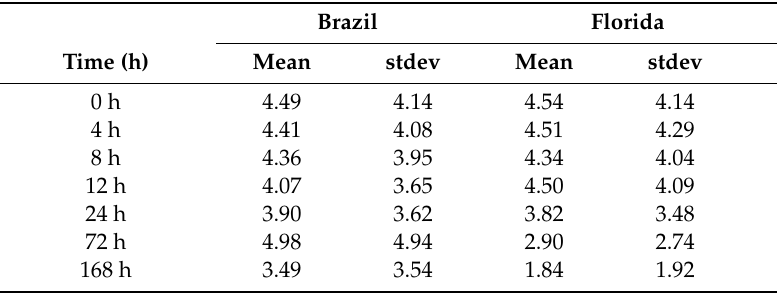
Table 6. Mayaro virus titer (plaque forming unit equivalents / mL) in cohorts of mosquitoes sampled for genes involved in mosquito immune pathways to Alphaviruses . For each time point and group, a sample included a pool of 10 mosquitoes, each with three-fold